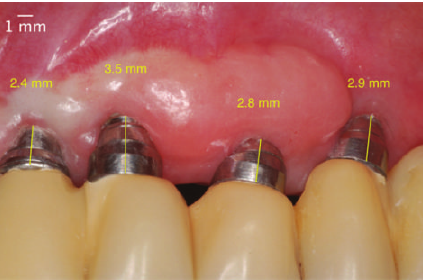
Figure 10: Postoperative aspect 7 days after surgery.